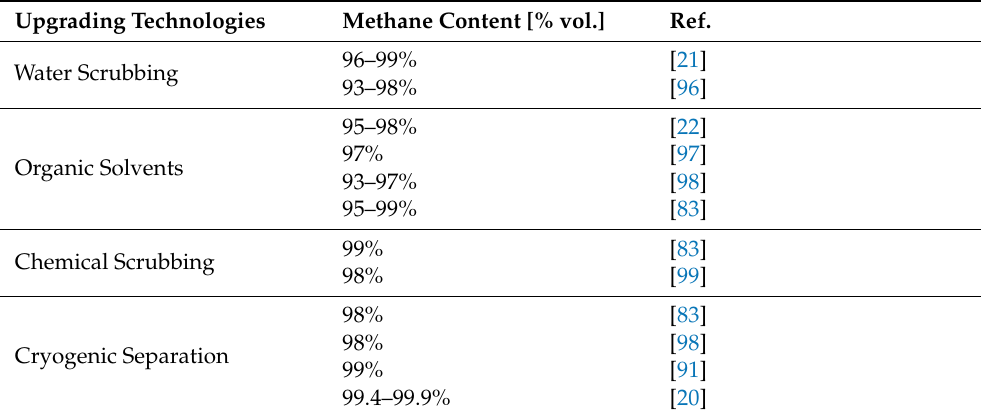
Table 8. Comparison data of methane content in biomethane produced through cryogenic separa- tion versus biomethane produced through commercial, well-known, technologies. Adapted with permission from Sun et al. [80]; published by Elsevier, 2015.